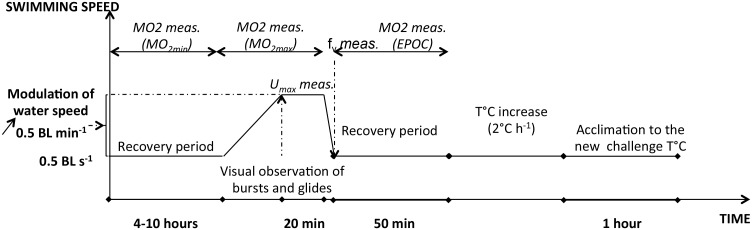
Diagram of the experimental protocol used for the thermal challenge.This diagram presents the evolution of swimming speed with time at one of the challenge temperature tested (i.e. 9°C, 12°C, 16°C, 20°C or 24°C). The different measures recorded for each fish and at each temperature are indicated in italic. MO2min: minimum oxygen consumption; MO2max: maximum oxygen consumption; Umax: maximum swimming speed; fv: ventilation rate after the MO2max challenge; EPOC: the excess post-oxygen consumption recorded during the recovery period following the swim challenge. The same protocol was repeated until each fish had been exposed to all challenge temperatures; one hour-acclimation to each new experimental challenge temperature was respected.